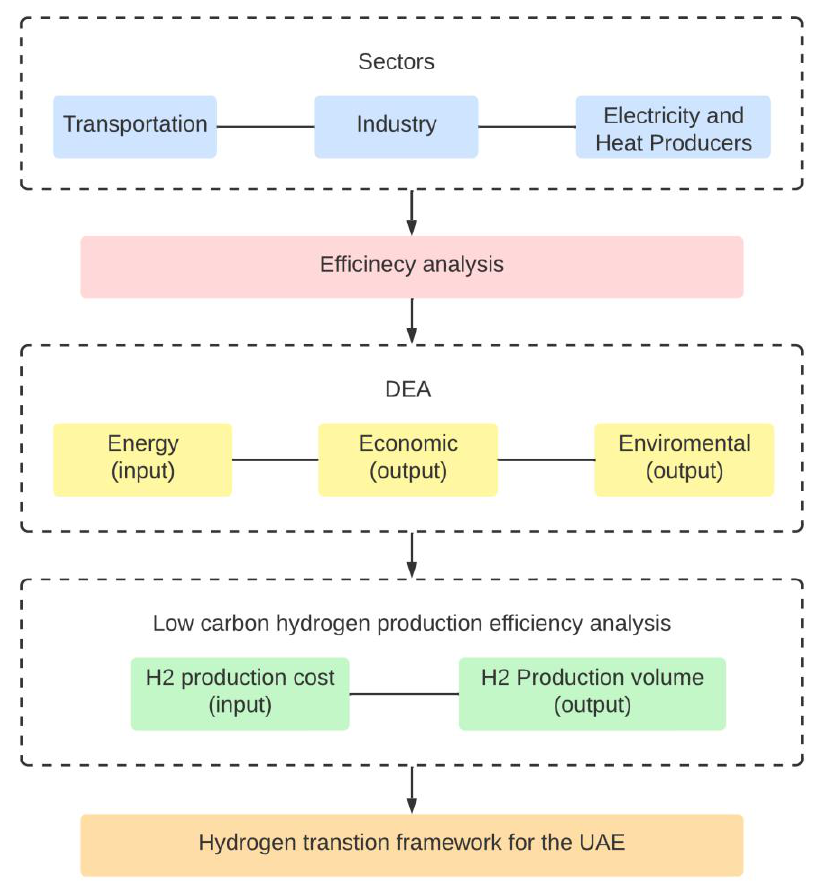
Figure 3. Analysis Figure 3. Analysis framework.